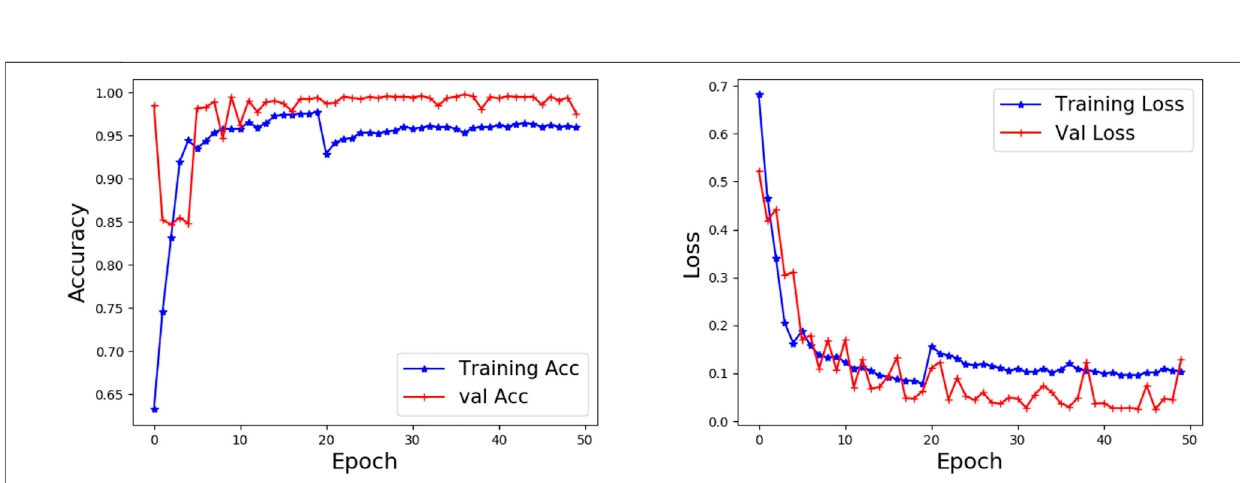
Frontiers in Computer Science |